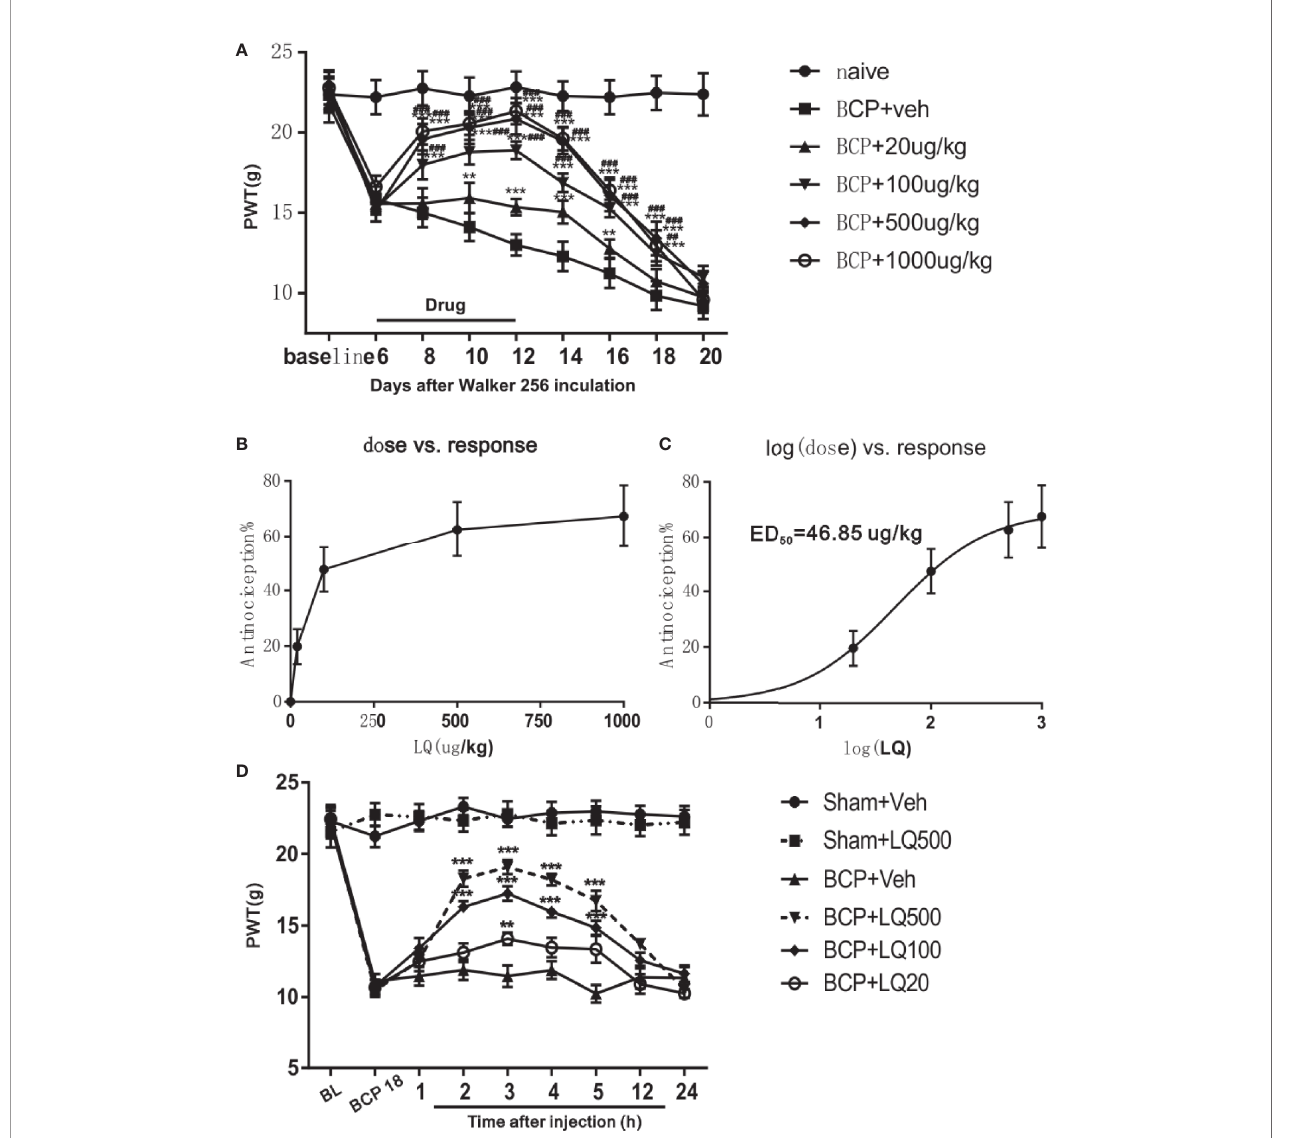
FIGURE 3 | Effects of intrathecal Liquiritin (LQ) administration on bone cancer induced mechanical allodynia. (A) Intrathecal injection of LQ dose-dependently alleviated the mechanical allodynia in bone cancer pain (BCP) rats and this effect was still observed 6 days after drug withdrawal on day 18 (F 5,42 = 21.4, **P < 0.01, ***P < 0.001 vs. BCP + Veh group, ## P < 0.01, ### P < 0.001 vs. BCP + 20 m g/kg group; n = 8, two way ANOVA, 3A ). The dose-effect or log (dose)-effect curves for the analgesic effects of intrathecally administered LQ were shown in (B , C) . The ED50 of LQ on bone cancer-induced mechanical allodynia was 46.85 m g/kg. (D) Intrathecal injection of single-dose of LQ on postoperative day (POD) 18 i.t. still alleviated paw withdrawal thresholds (PWT). The effects reached peak at 3 h after injection and then gradually faded away, where only the 20 ug/kg works at 3 h after injection. (F 5,42 = 105.8, **P < 0.01, ***P < 0.001 vs. BCP + Veh group; n = 8, two way